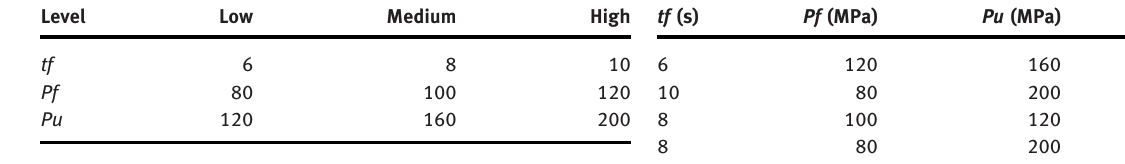
Table 2: List of actual and corresponding values of tf , Pf and Pu . Level Low Medium